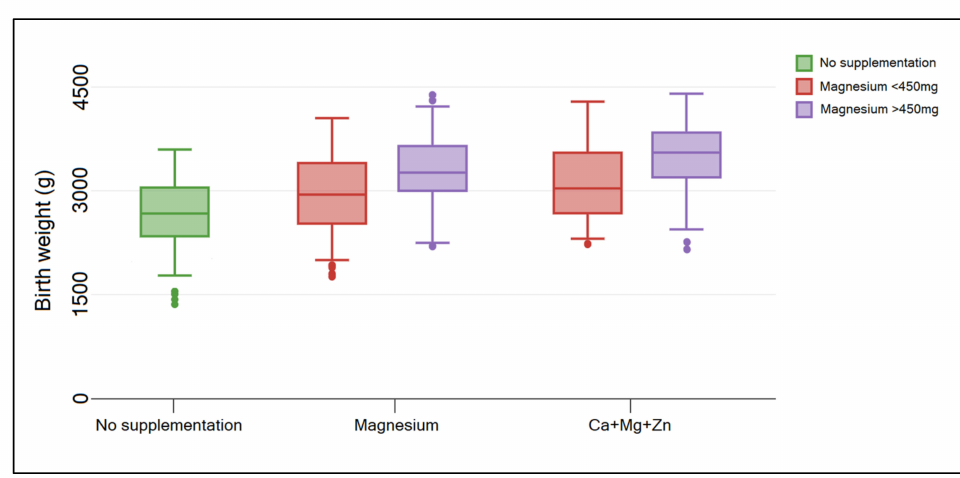
Figure 1. Box-plot of newborn birth weight from mothers with COVID-19 during pregnancy, stratified by nutritional supplementation with magnesium-based supplements and magnesium dose. Data analyzed by Kruskal–Wallis